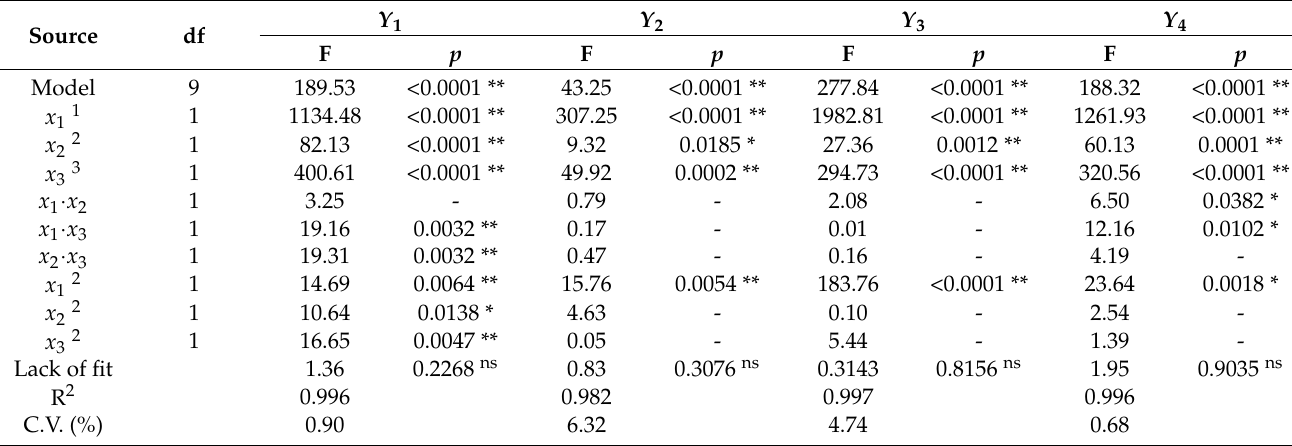
Table 3. ANOVA evaluation of linear, quadratic, and interactive terms for each response variable of the spray drying process.